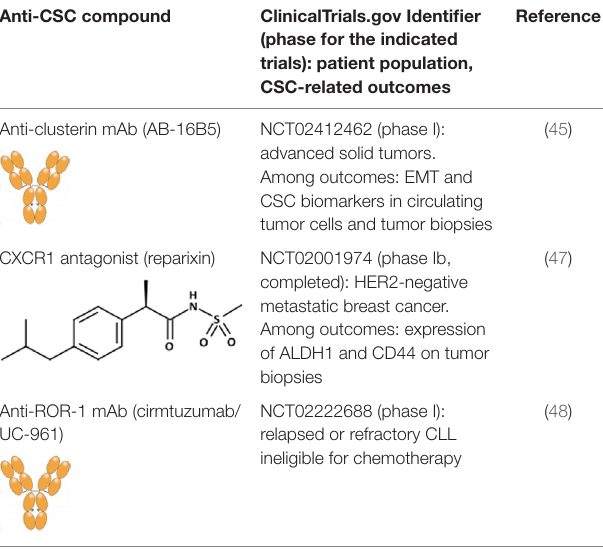
TABLe 1 | Anti-CSC compounds targeting cell surface